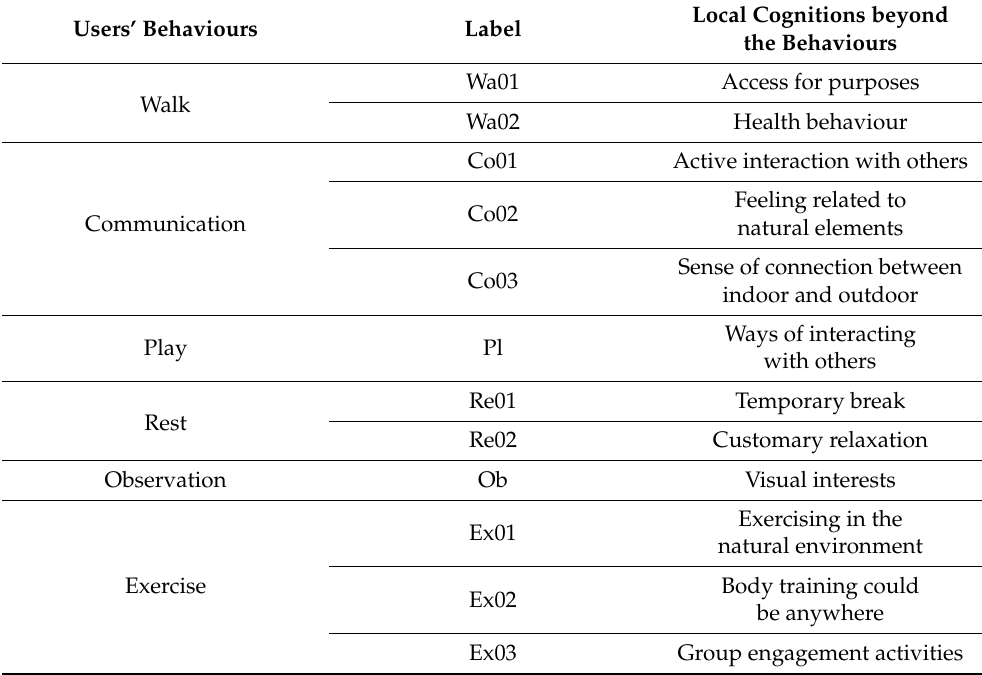
Table 4. Labelling users’ behaviours with local cognitions beyond.